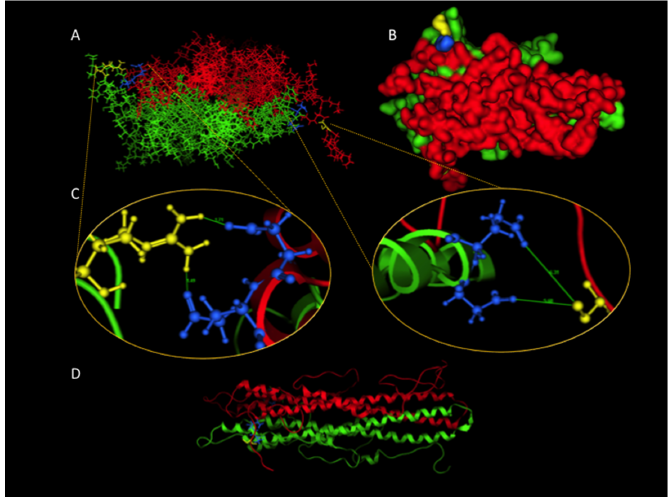
Figure 2. Molecular modeling of the LAP2 α dimer. ( A ) Graphical representation of LAP2 α hetero- dimer formed by one wild-type (green) and one 690Cys (red) subunit. Side chains in position 690 are depicted in yellow, and nearby aspartate 538 and glutamate 539 residues from the other subunits are depicted in blue. These residues form an interchain electrostatic contact in the wild-type form. ( B ) Heterodimer view rotated about 90° around the horizontal and perpendicular axes. ( C ) Zoom to both interchain contacts involving residue 690. The left panel shows the wild-type arginine forming ionic pairs with aspartate and glutamate, and electrostatic interchain contacts. The right panel shows the modeled interface with the Arg690Cys polymorphic chain, resulting in the loss of inter- chain contact, allowing the other chain to move apart during modeling. ( D ) Lateral view of the LAP2 α dimer in ribbon representation to emphasize interface contact and dimer symmetry.